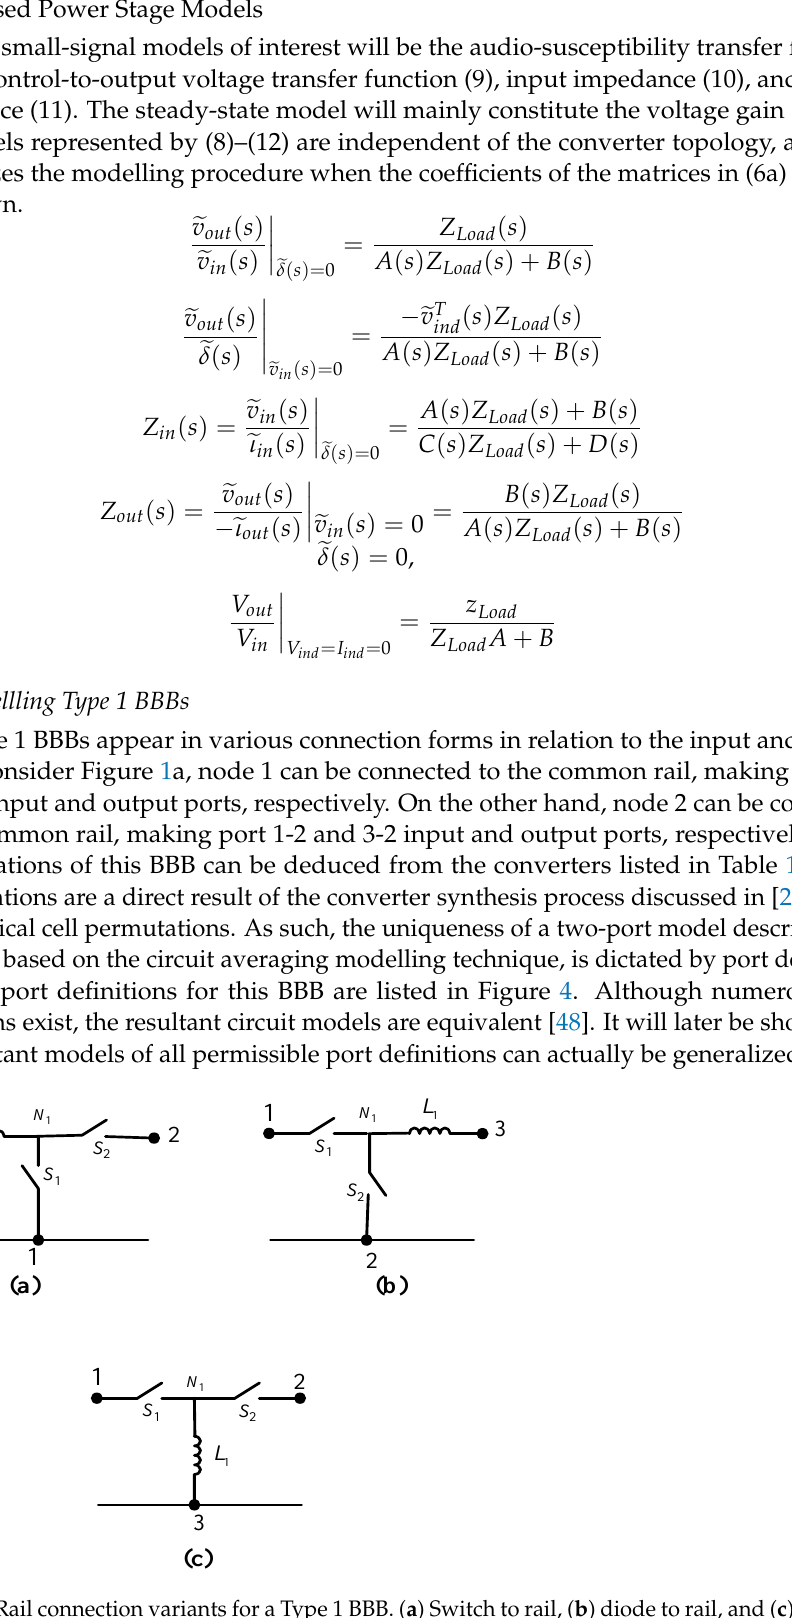
Figure 4. Rail connection variants for a Type 1 BBB. ( a ) Switch to rail, ( b ) diode to rail, and ( c ) inductor to rail.